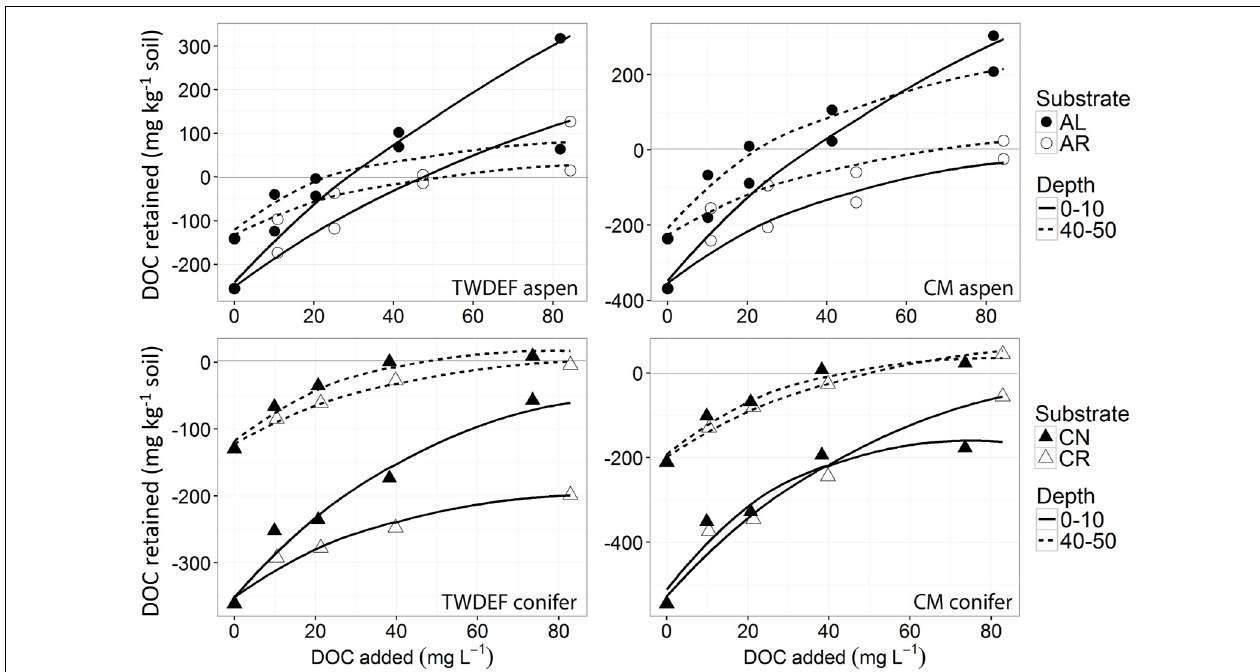
FIGURE 2 | Non-linear isotherms representing release/retention of dissolved organic carbon (DOC) from aspen leaves (AL) and aspen roots (AR) on aspen soils (upper two graphs) , and of fir needles (CN) and fir roots (CR) on conifer soils (lower two graphs) from TWDEF and CM sites. The y -axis indicates DOC retention in the area above zero, and DOC release in the area below the zero-line. The SE of laboratory replicates was mostly < 5%.